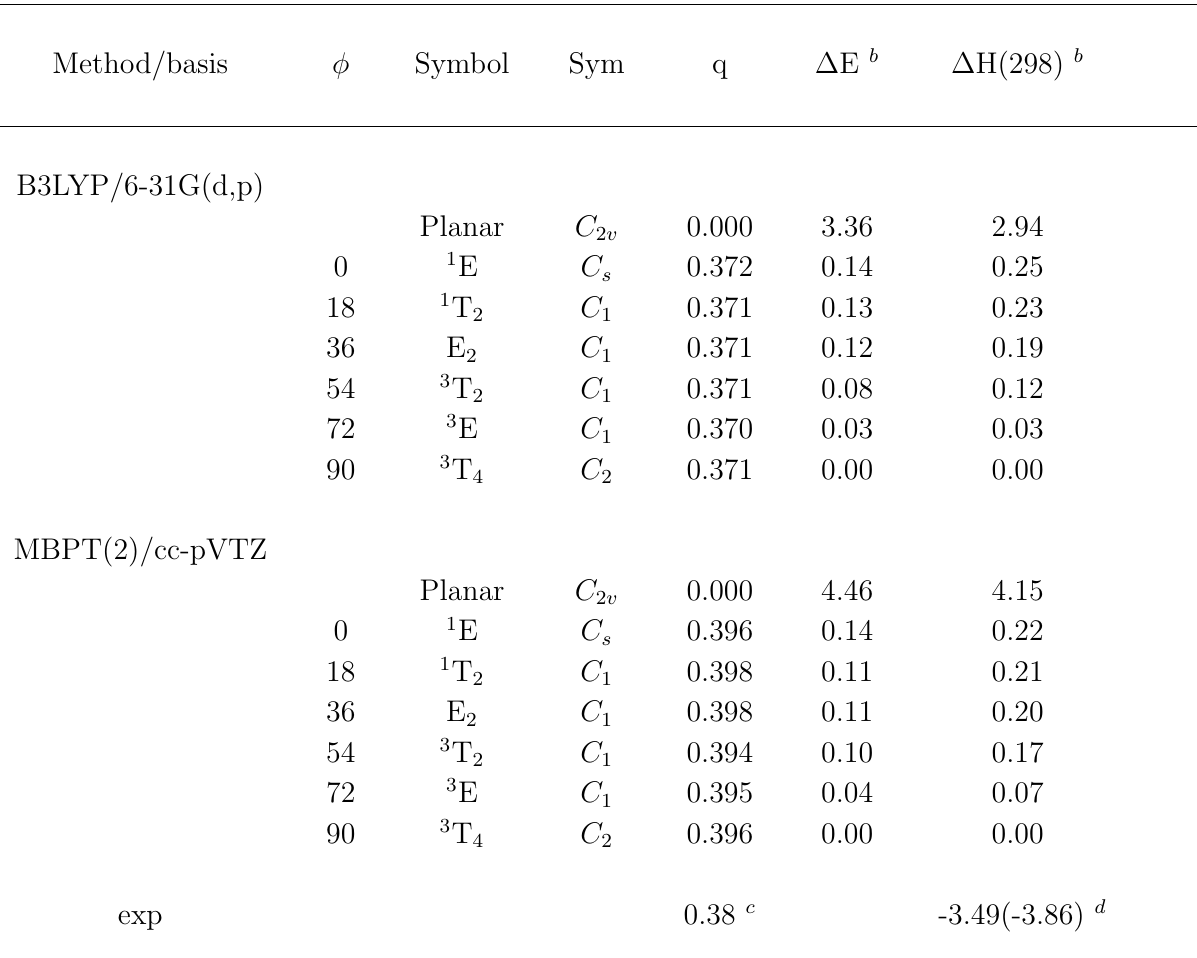
Table 1. Calculated puckering coordinates, energies, and enthalpies of THF.